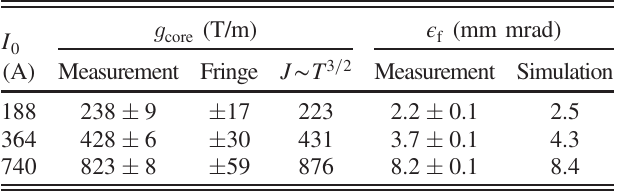
TABLE I. Comparison of measured and simulated gradients and emittances. The measured gradients are for an effective length of L ¼ 7 . 5 mm. Additionally, systematic uncertainties arising from the fringe fields are given. The emittance was simulated for σ ¼ 154 μ m and a field in the form of the J ∼ T 3 = 2 - model (cf. Fig. 1).